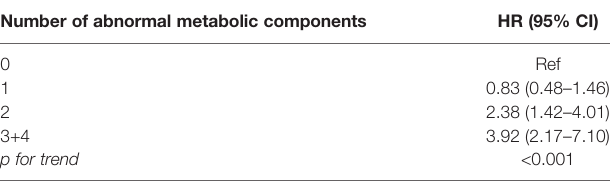
The HR (95% CI) adjusted for age, sex, smoking, drinking, physical activity, and family history of diabetes. T2DM, type 2 diabetes mellitus; HR, hazard